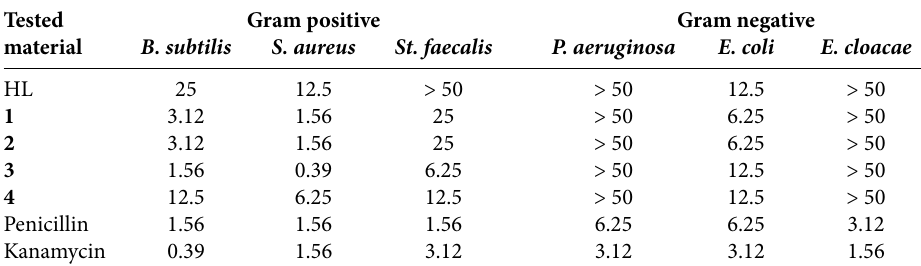
Table 4. MICs (μg mL –1 ) of the compounds and related materials Tested